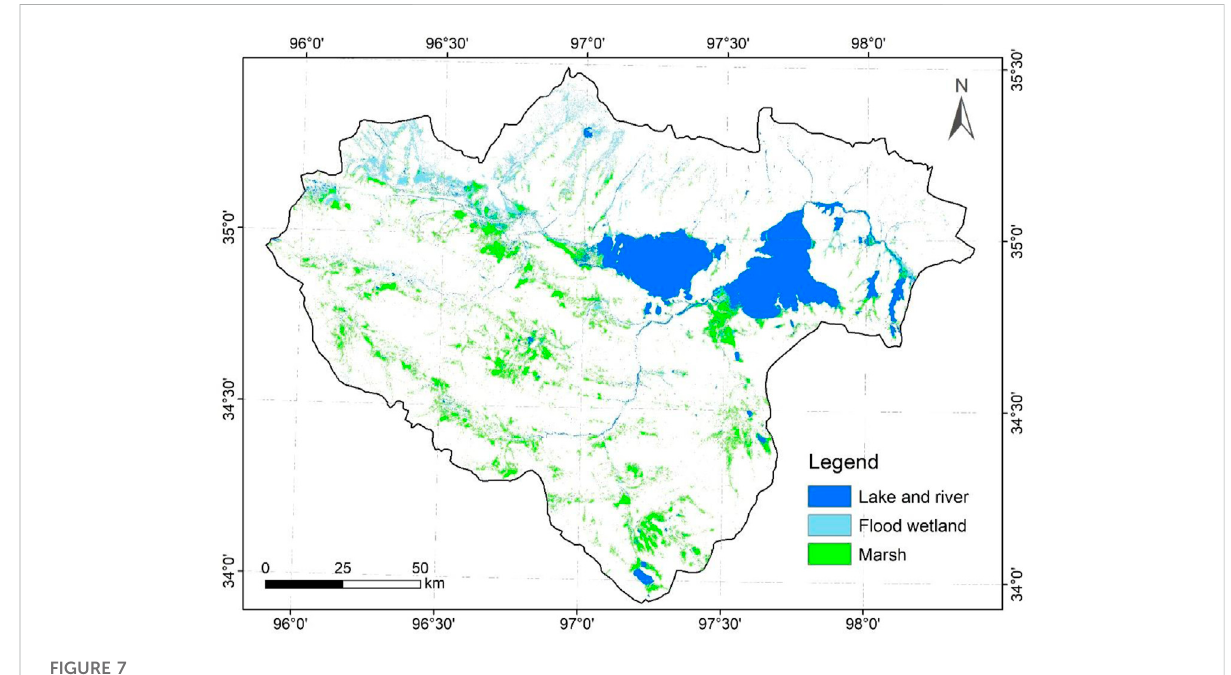
Spatial distribution of wetlands in the HAYR.